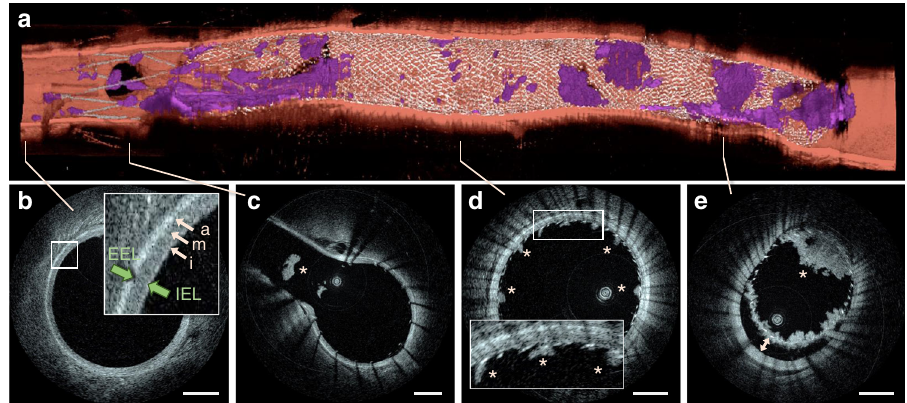
Fig. 6 HF-OCT volumetric microscopy of an intracranial stent partially overlapping with the distal end of a fl ow diverting stent. a Three-dimensional rendering showing signi fi cant thrombus accumulation. b HF-OCT microscopy depicts the vessel wall microstructure including the individual vessel layers comprising a bright tunica intima, a low-scattering tunica media, and the tunica adventitia (arrows). The internal elastic lamina (IEL) and the external elastic lamina (EEL) are indicated by the green arrows. c A thrombus dislodged from the surface of the device fl oating inside a large branch is visible and denoted by the asterisk. d Thrombus formations ranging between 100 and 200 µ m in thickness are indicated by the asterisks and distributed over the FDS surface. e A semi-occlusive clot formation in correspondence of a signi fi cant malapposition (>500 µ m) is visible over the proximal end of the FDS. HF-OCT imaging was repeated in a total of n = 15 swine internal maxillary arteries with an intracranial stent partially overlapping with a fl ow-diverting stent. Scale bars are equal to 1.0 mm. Three-dimensional endoscopic rendering color scheme: red, artery wall; purple, clot; silver, fl ow-diverting stent struts; gray, neurovascular stent struts.